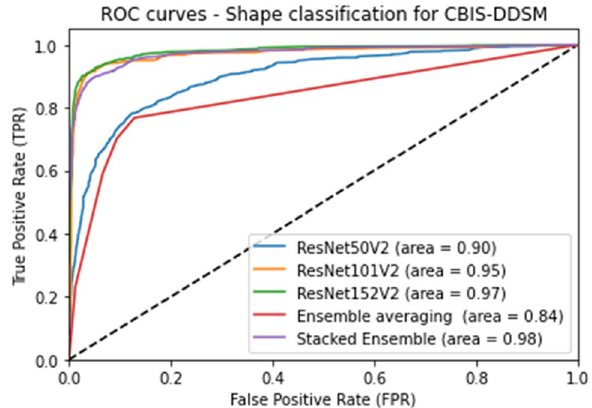
Figure 8. Performance of Shape classification using different models in terms of ROC curves and AUC score.